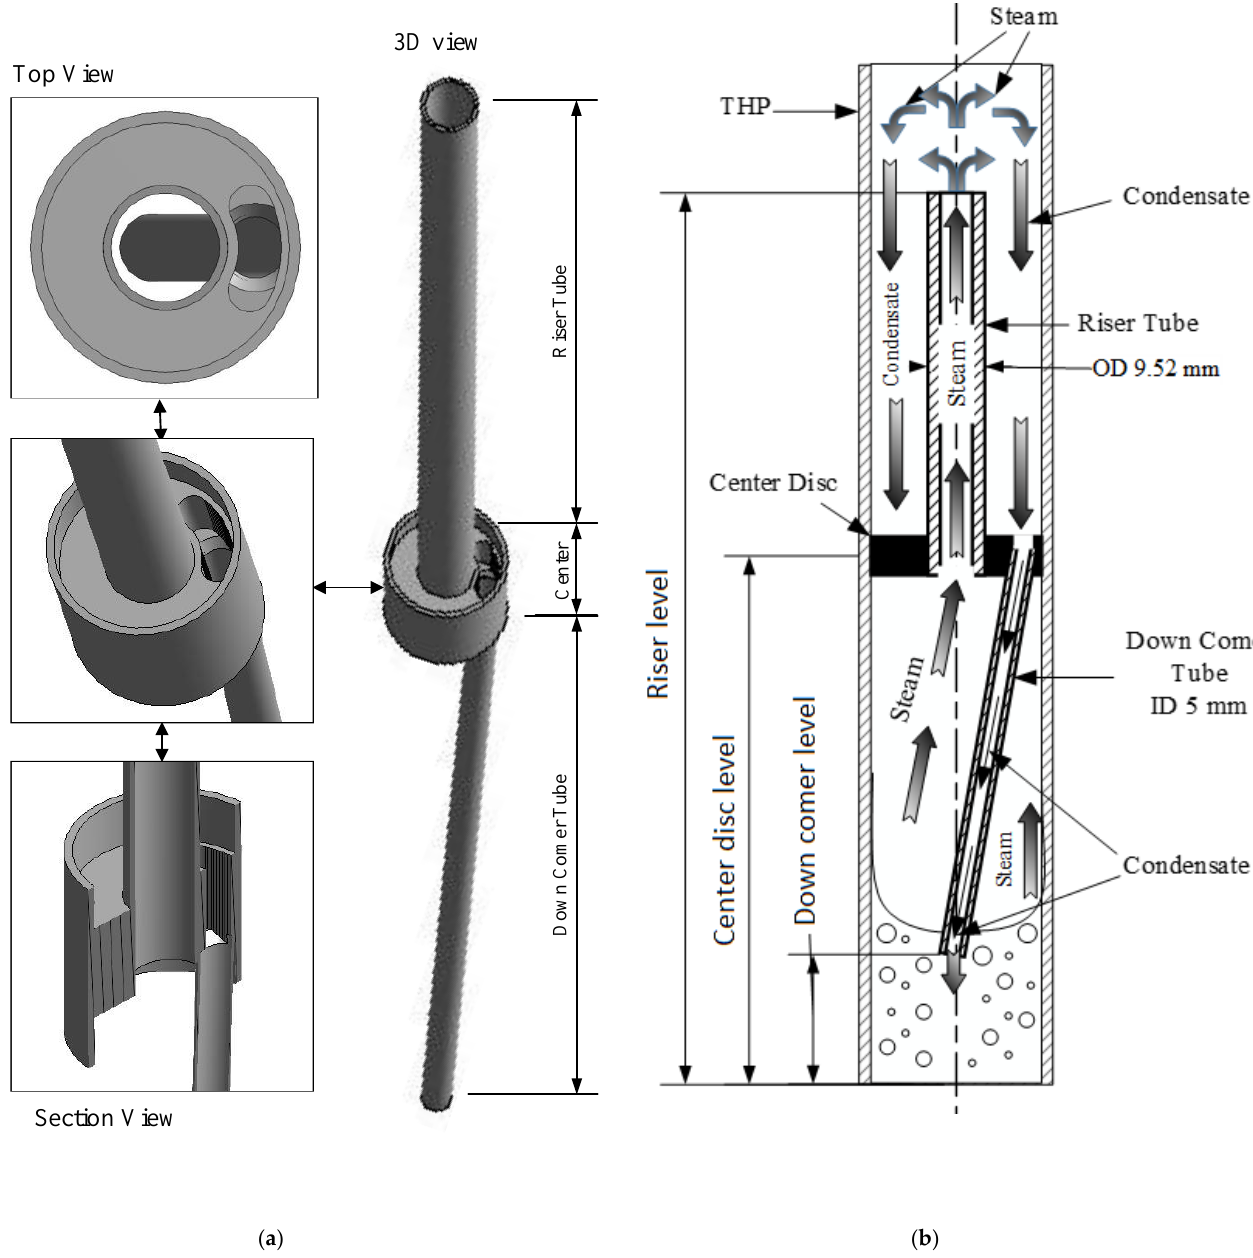
Figure 3. ( a ) Schematic diagram of new design with (TP); and ( b ) the new design of the TPTHP (with TP).